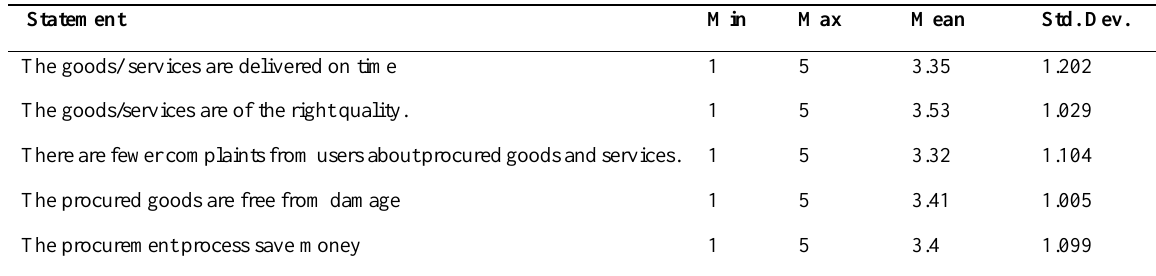
Table 3: Procurement